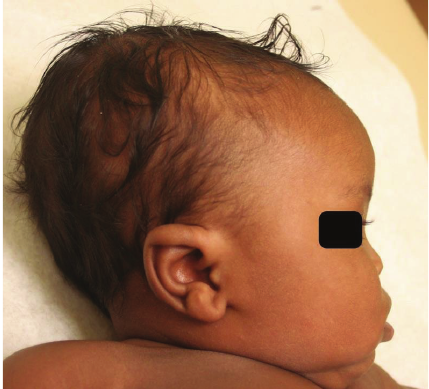
Figure 4: Facial profile 2 months after delivery shows nasal hyp- oplasia consistent with previous